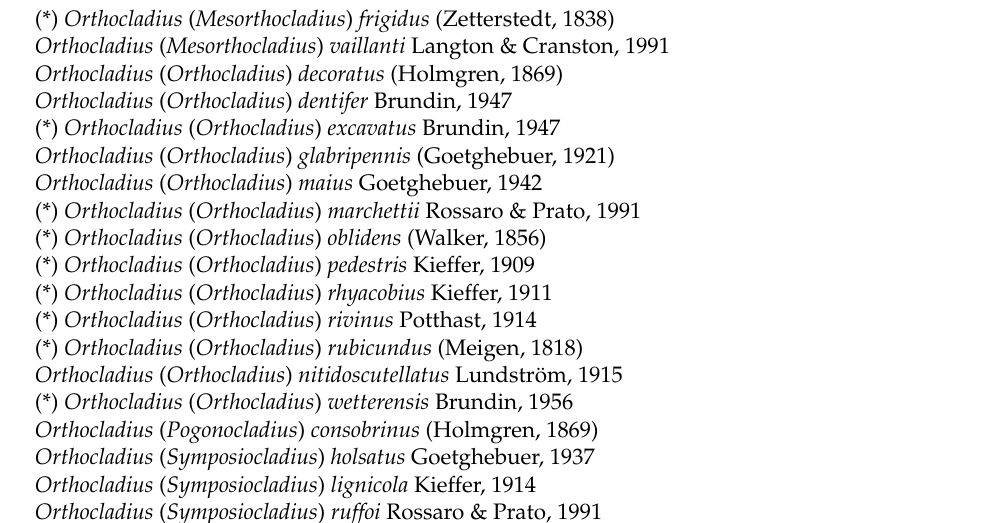
Table 1. List of the species considered in the key. (*) Orthocladius ( Mesorthocladius ) frigidus (Zetterstedt, 1838) Orthocladius ( Mesorthocladius ) vaillanti Langton & Cranston, 1991 Orthocladius ( Orthocladius ) decoratus (Holmgren, 1869) Orthocladius ( Orthocladius ) dentifer Brundin, 1947 (*) Orthocladius ( Orthocladius ) excavatus Brundin, 1947 Orthocladius ( Orthocladius ) glabripennis (Goetghebuer, 1921) Orthocladius ( Orthocladius ) maius Goetghebuer, 1942 (*) Orthocladius ( Orthocladius ) marchettii Rossaro & Prato, 1991 (*) Orthocladius ( Orthocladius ) oblidens (Walker, 1856) (*) Orthocladius ( Orthocladius ) pedestris Kieffer, 1909 (*) Orthocladius ( Orthocladius ) rhyacobius Kieffer, 1911 (*) Orthocladius ( Orthocladius ) rivinus Potthast, 1914 (*) Orthocladius ( Orthocladius ) rubicundus (Meigen, 1818) Orthocladius ( Orthocladius ) nitidoscutellatus Lundström, 1915 (*) Orthocladius ( Orthocladius ) wetterensis Brundin, 1956 Orthocladius ( Pogonocladius ) consobrinus (Holmgren, 1869) Orthocladius ( Symposiocladius ) holsatus Goetghebuer, 1937 Orthocladius ( Symposiocladius ) lignicola Kieffer, 1914 Orthocladius ( Symposiocladius ) ruffoi Rossaro & Prato,